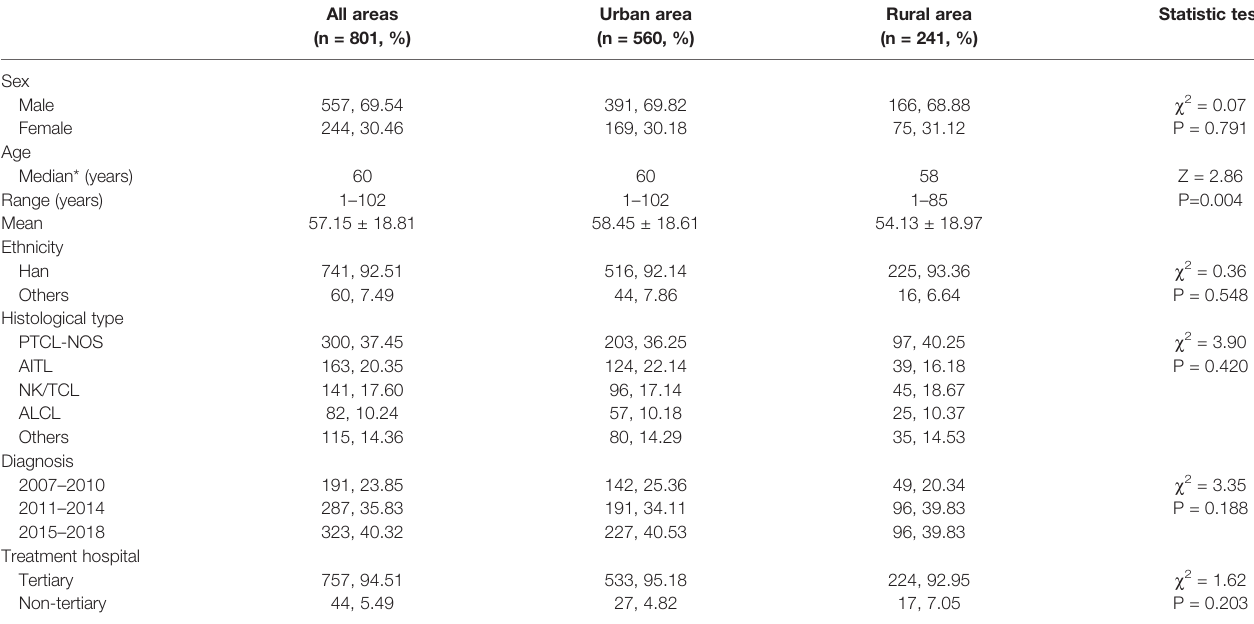
TABLE 1 | Baseline characteristics of 801 patients with peripheral T-cell